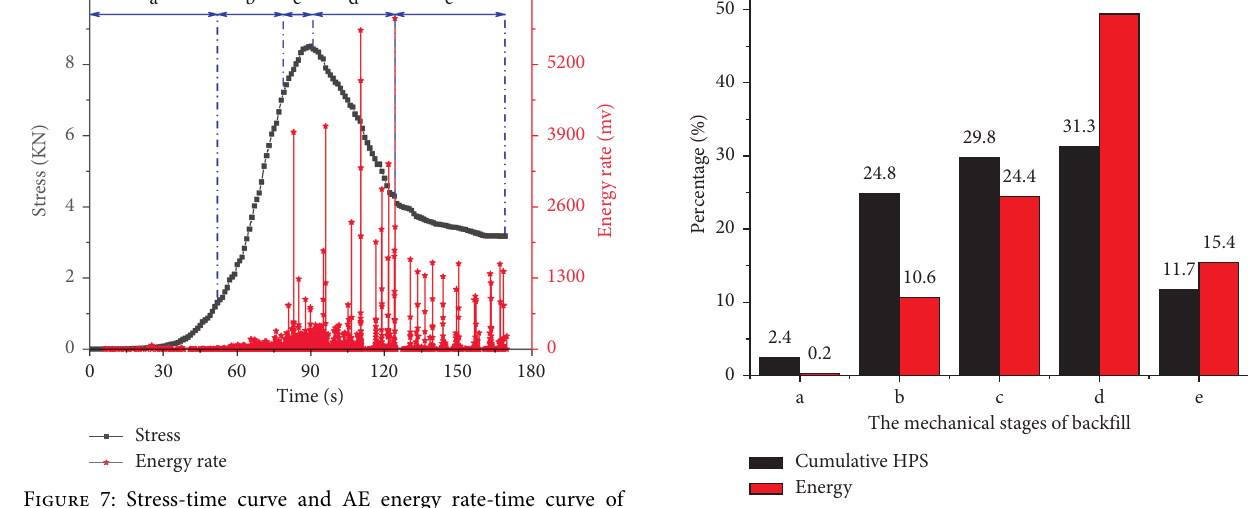
Figure 9: The proportion of A.E. signals in different stages.